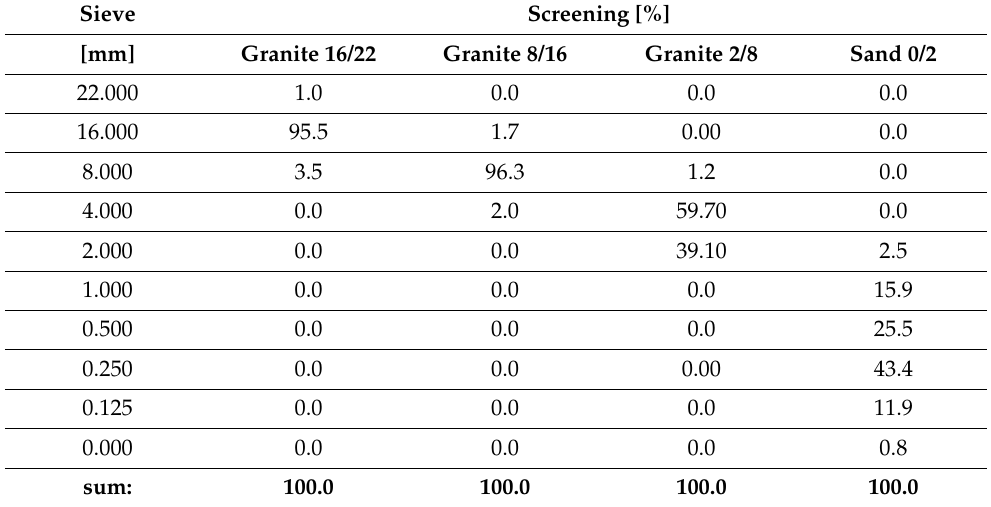
Table 3. Graining of